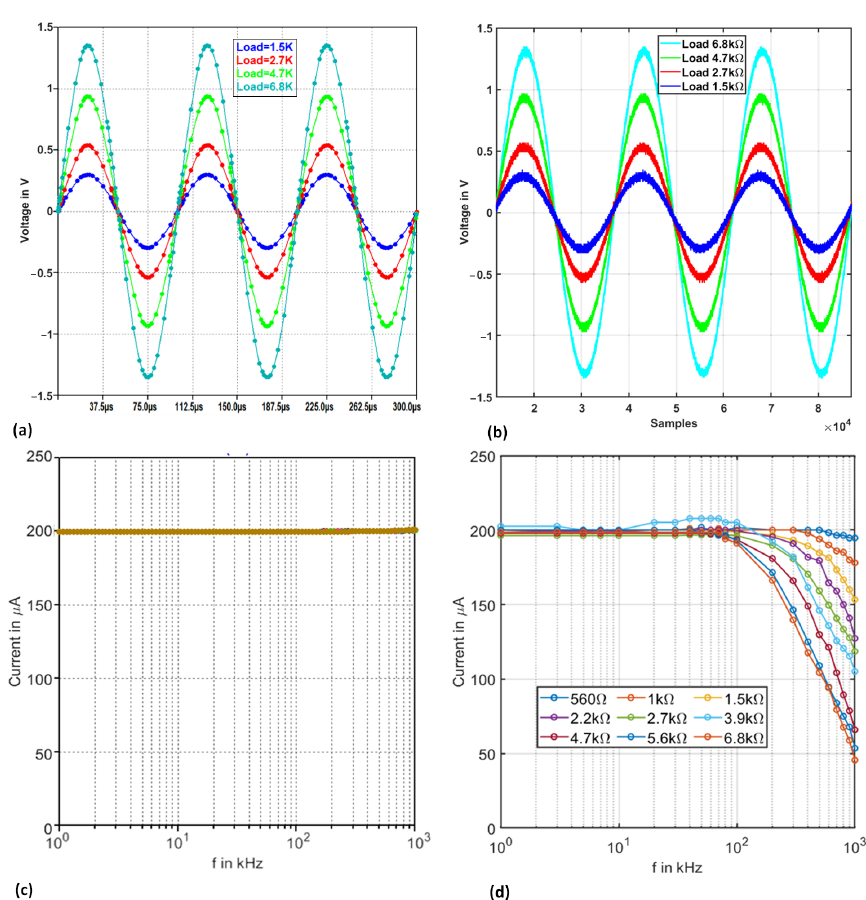
Figure 6. VCCS analysis: Output signal cross the load for transient analysis: ( a ) simulation results, ( b ) implementation results, AC analysis, ( c ) simulation results, and ( d ) implementation